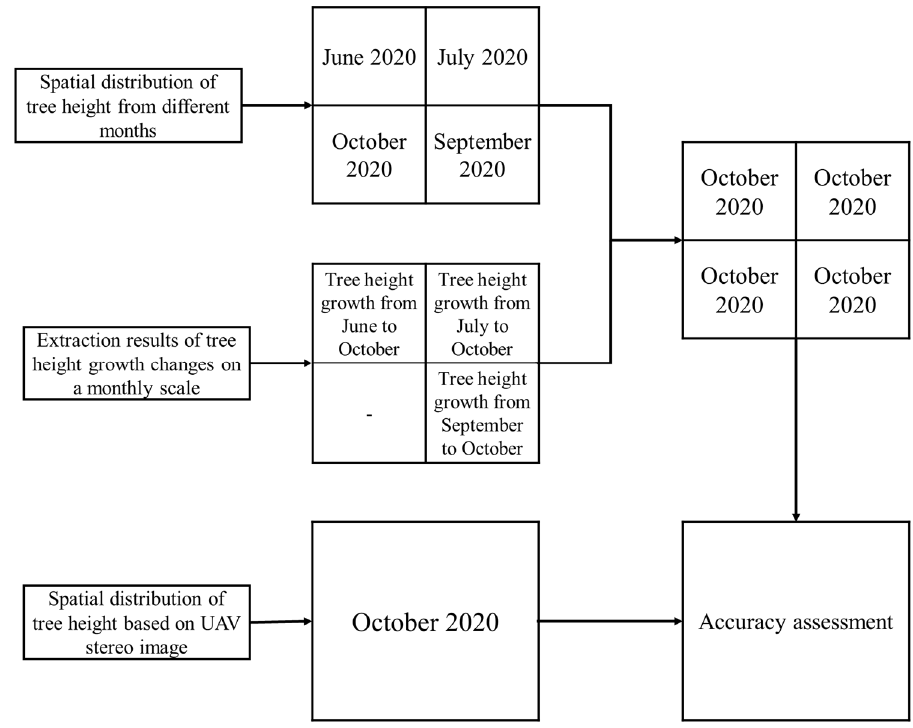
Figure 3. Simulation diagram of the time difference correction of tree height estimates.